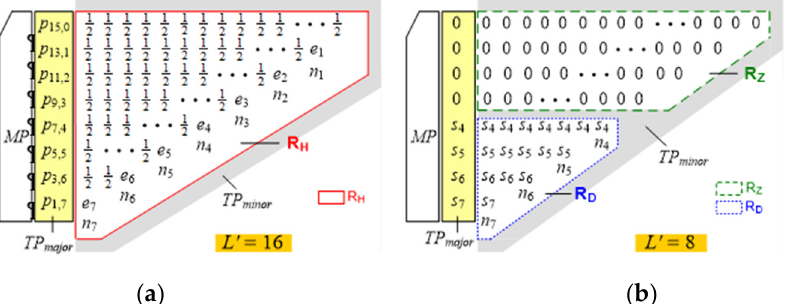
Figure 3. Schematic for the TP minor contents of a 16-bit Booth multiplier for other L ′ -bit inputs : ( a ) L ′ = 16 and ( b ) L ′ = 8.